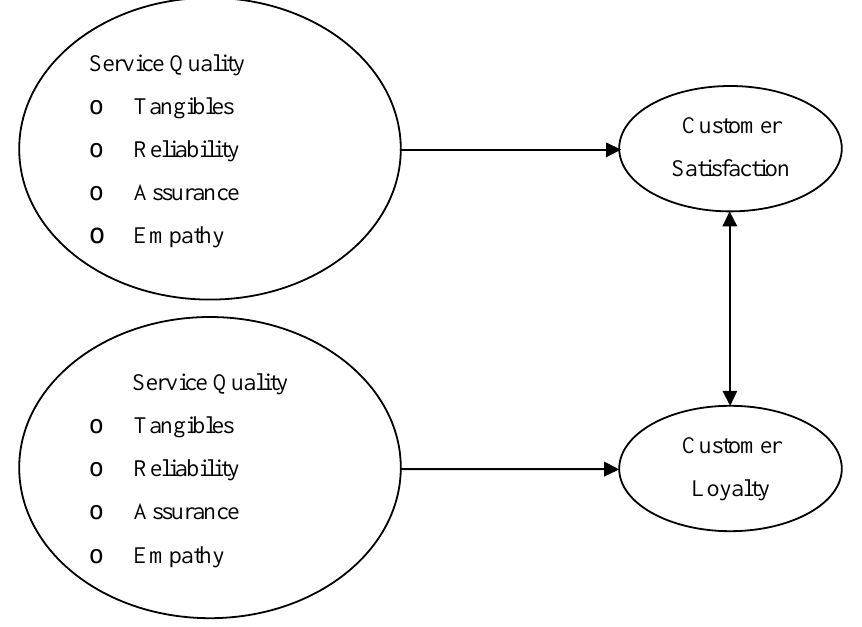
Figure 1: Theoretical Framework of the